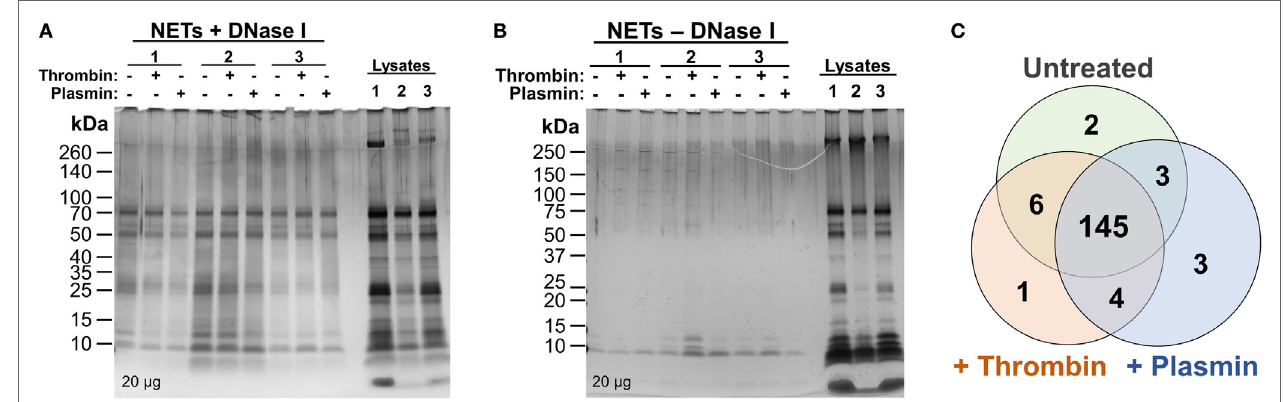
FigUre 2 | Silver stains and initial comparison of neutrophil extracellular trap (NET)-proteins. (a,B) Proteins extracted from NETs were quantified and loaded (20 µg) onto 4–20% Tris–Glycine gradient gels. Silver staining was then performed— (a) DNase I-treated samples and (B) non-DNase I-treated samples. (c) Proteins identified as NET-bound (as illustrated in Figure S1 in Supplementary Material) from untreated, 1 µM thrombin-, or 1 µM plasmin-treated samples were compared using Venn